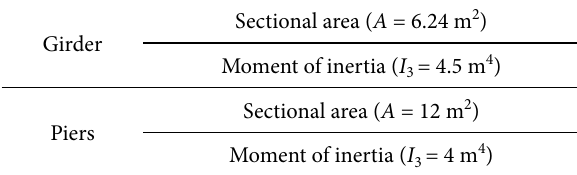
Table 2 . Section properties of the selected bridge